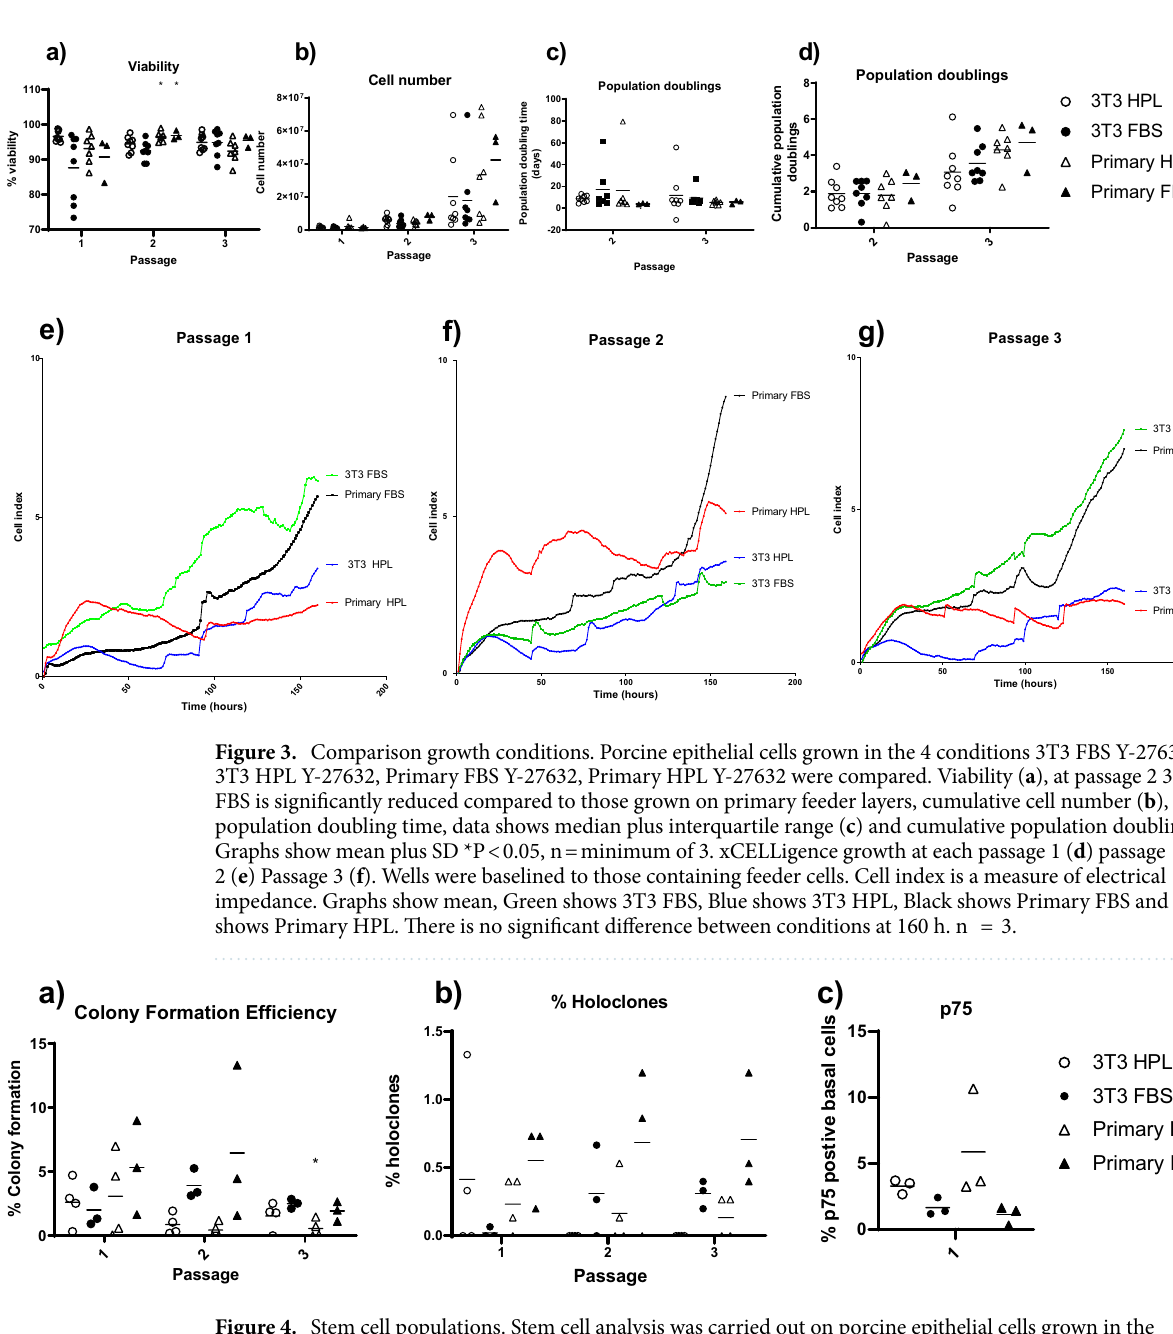
Figure 4. Stem cell populations. Stem cell analysis was carried out on porcine epithelial cells grown in the 4 conditions 3T3 FBS Y-27632, 3T3 HPL Y-27632, Primary FBS Y-27632, Primary HPL Y-27632,for Colony formation efficiency (CFE) assay all colonies were counted, by passage 3 those on primary HPL Y-27632 are significantly reduced compared to FBS 3T3 Y-27632 *P > 0.05 ( a ). Holoclones colonies larger than 10 mm with round edges were counted, there was no significant difference between the conditions ( b ). P75 was measure using Flow cytometry at passage 3. There was no significant difference between the conditions ( c ). Data shows mean plus SD, n =